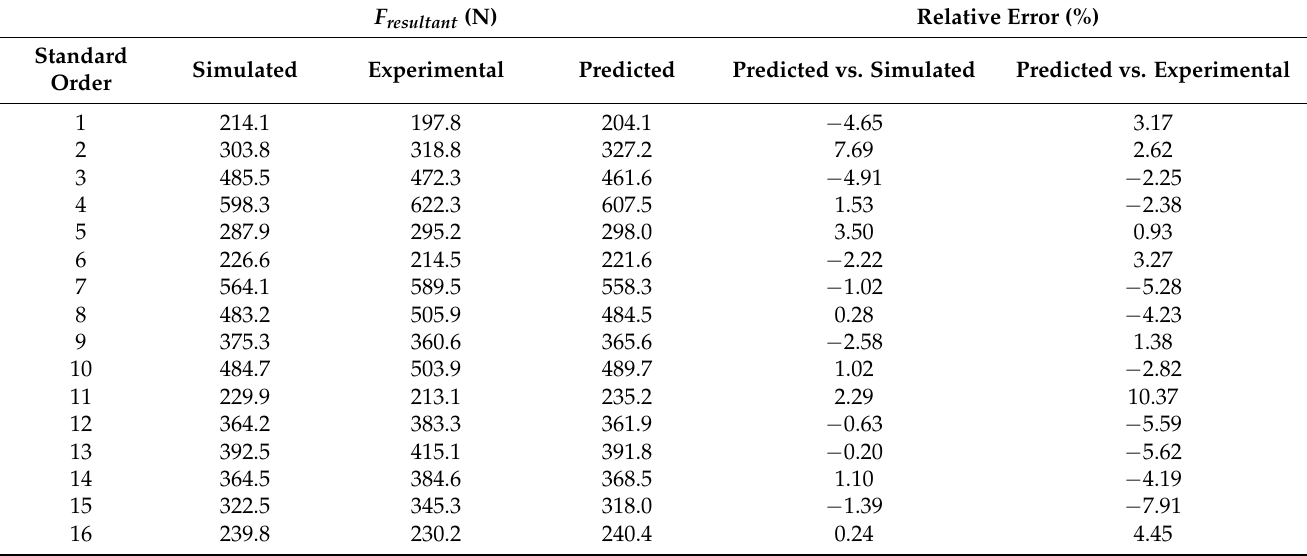
Table 5. Comparison of the resultant machining